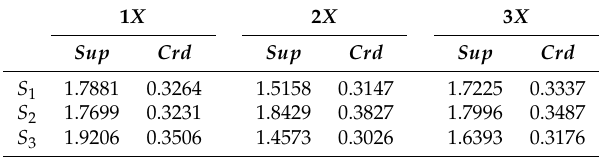
Table 4. The support degree Sup and credibility degree Crd of the sensors under different features. 1